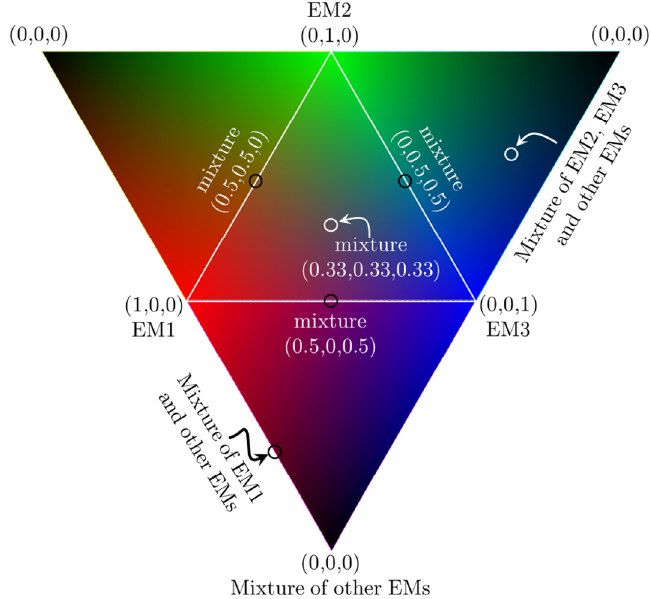
Figure 11. Planar unfolding of color pyramid for simultaneous representation of fraction maps of three EMs. Remote Sens. 2020 , 12 , x FOR PEER REVIEW 20 of 31